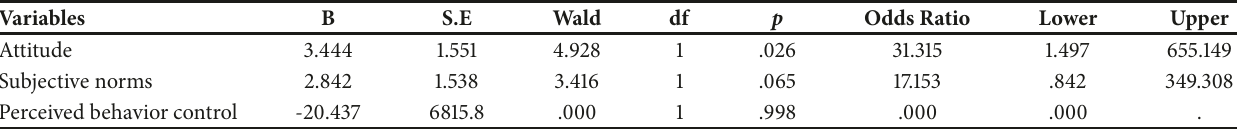
Table 5: The logistic regression predicting the likelihood of components of Theory of Planned Behavior to influence birth preparedness intention among male